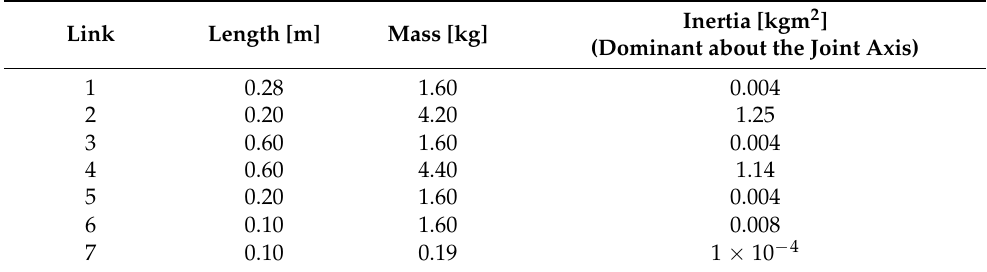
Table 1. Geometric and mass properties of the simulated robot.